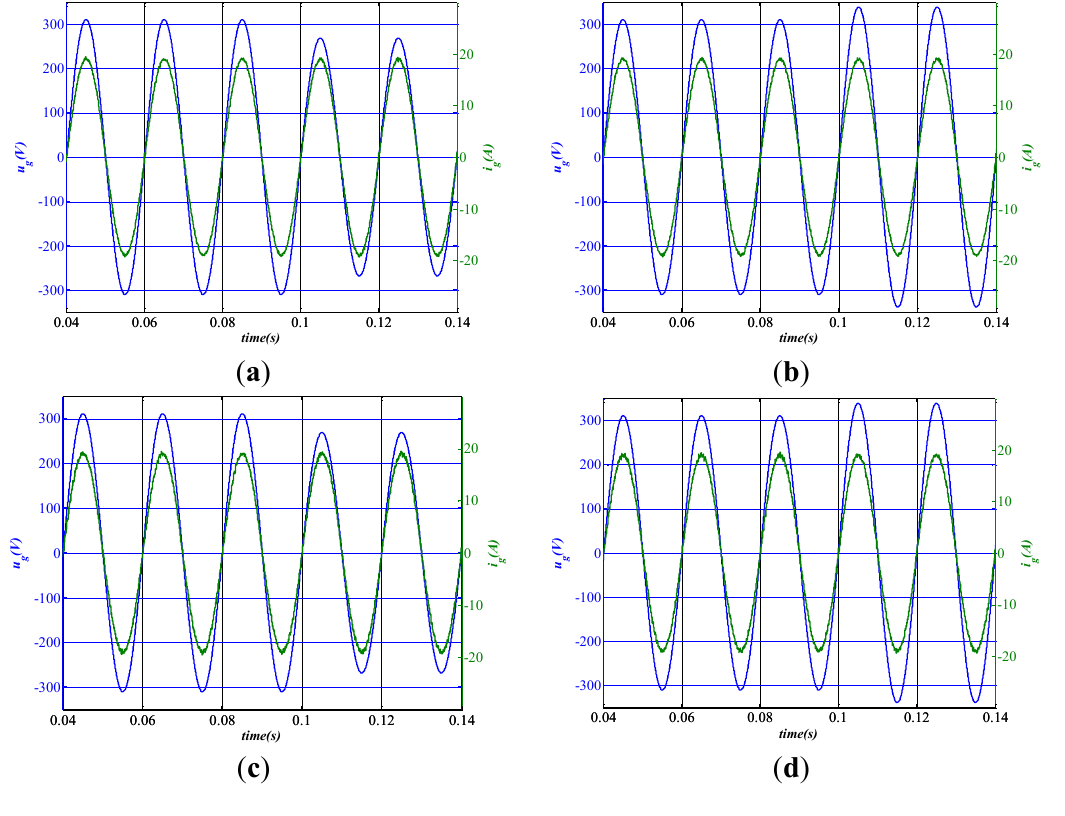
Figure 16. Grid voltage and injected current at full load with inductor L simulation results. ( a ) Inductor L increased by 20%: grid voltage sag; ( b ) Inductor L 1 increased by 20%: grid voltage swell; ( c ) Inductor L decreased by 20%: grid voltage sag; 1 ( b ) Inductor L decreased by 20%: grid voltage 1